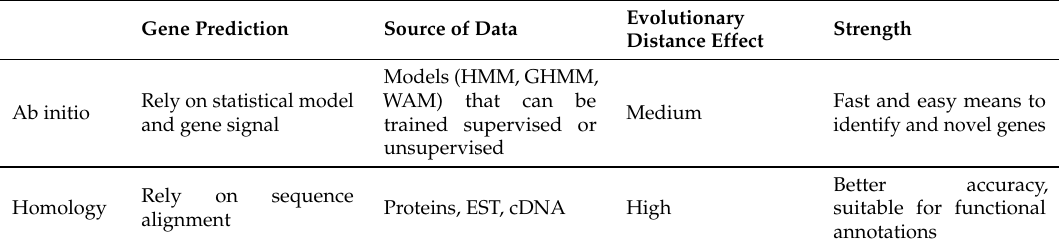
Table 3. Ab initio and Homology-based annotation tools